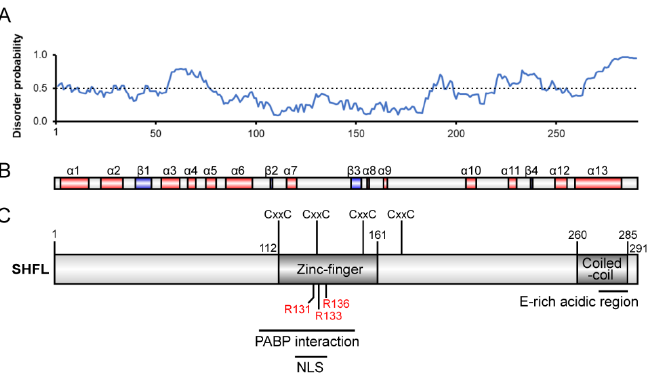
Figure 5. Predicted domains and features in SHFL . ( A ) Plot of predicted disorder probability vs. residue number (DISOPRED2 [60]), indicating a predominantly globular fold. ( B ) Prediction of secondary structural elements (PSIPRED [61]). ( C ) Annotated domain diagram of SHFL. The cen- tral CxxC motifs are highly conserved among family members (Pfam UPF0515). Other regions of interest include a putative zinc-finger domain, E-rich acidic domain, coiled-coil domain, nuclear localization sequence (NLS) and experimentally determined region necessary for interaction with PABP [47]. The locations of R131, R133 and R136 mutated in this study are indicated.